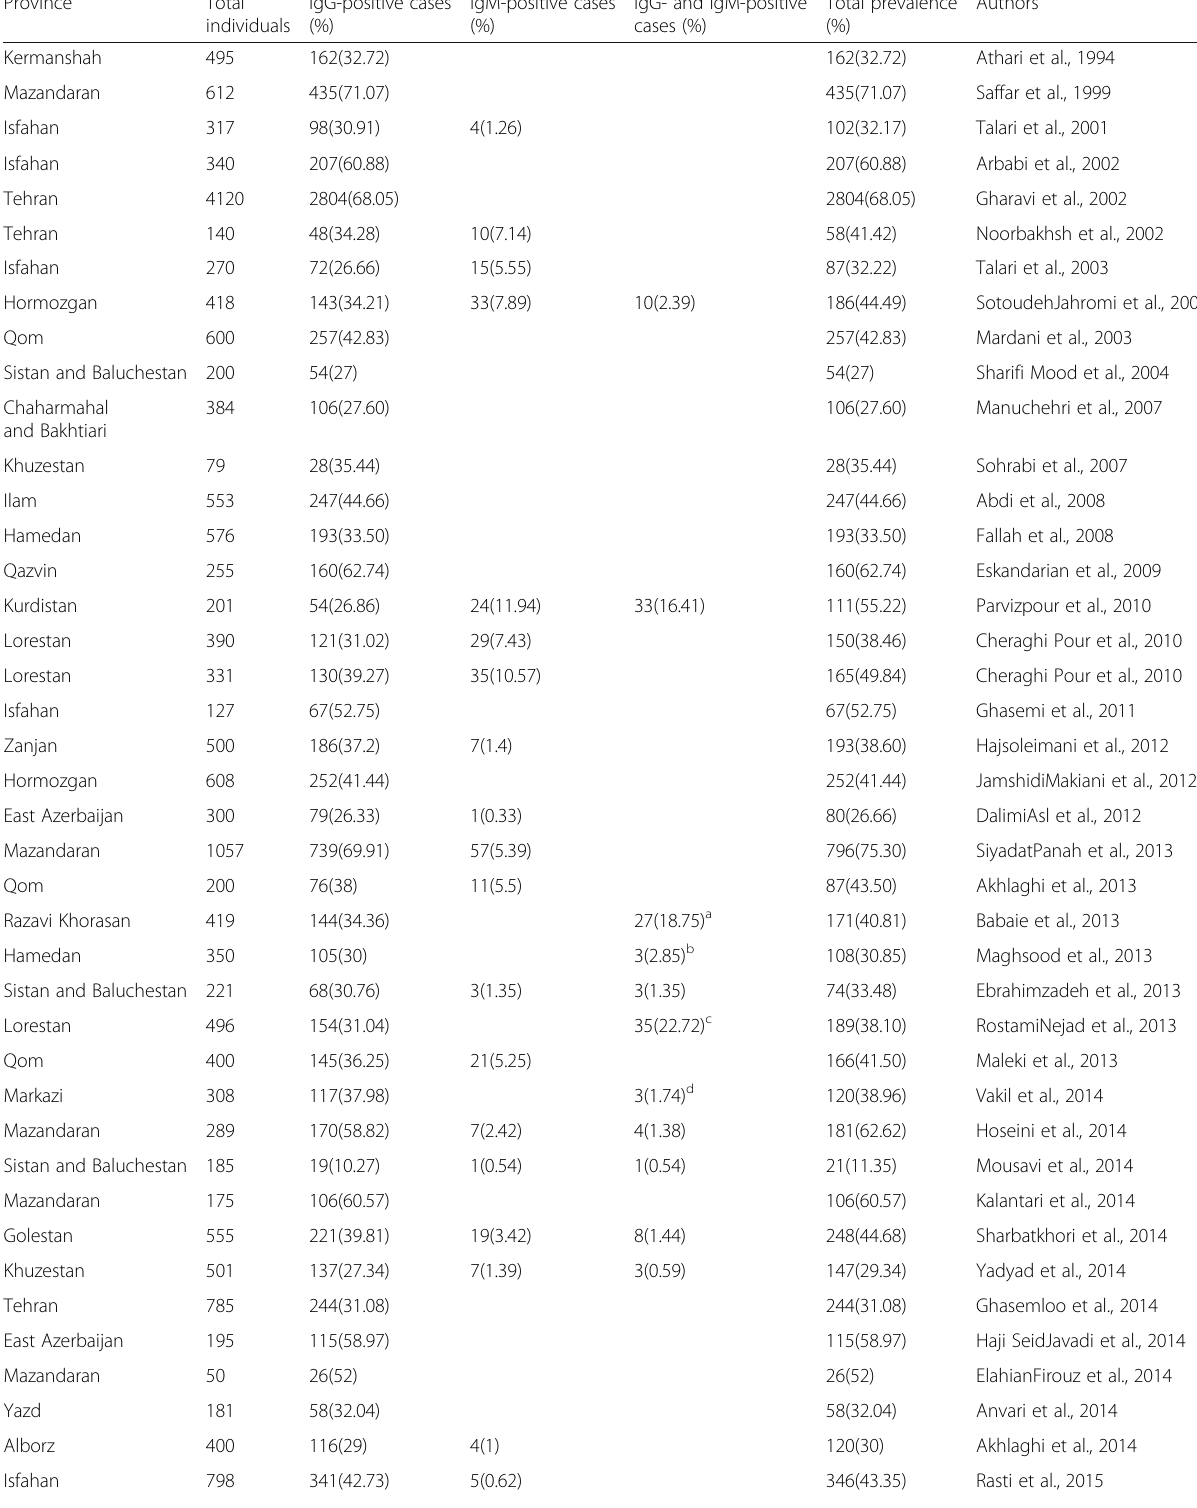
Table 3 Pregnant women group baseline characteristics of included studies